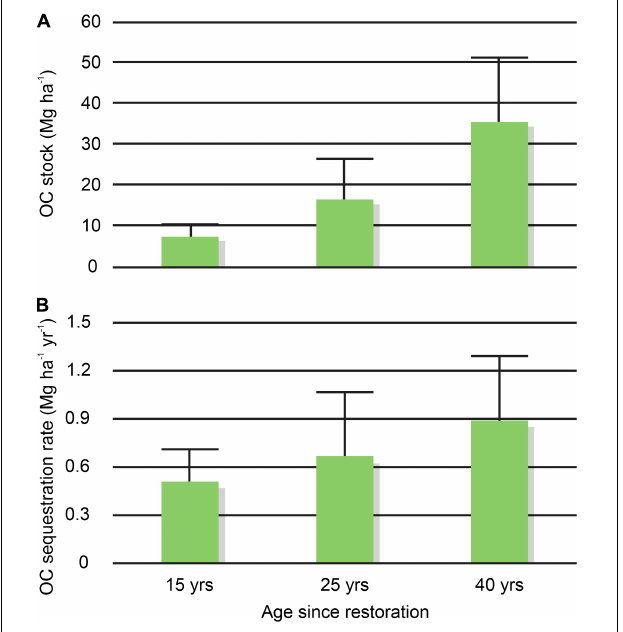
FIGURE 4 | (A) OC stocks and (B) sequestration rates for restored wetlands after 15, 25, and 40 years based on 210Pb dating. Error bars represent standard deviations.